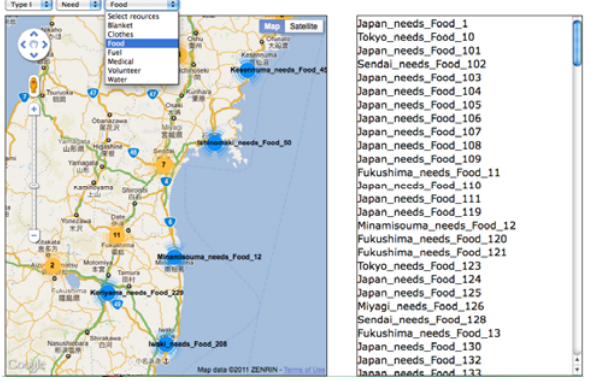
Figure 8. Geo-visualization of GeoSPARQL